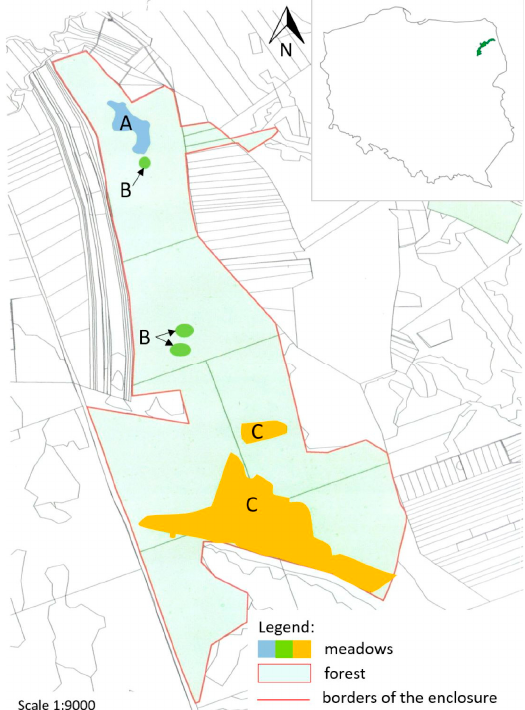
Figure 1. Location of the Biebrza National Park in Poland (right corner) and distribution of the non- forest habitats in the studied site. A—northern meadow, B—mid-forest meadows, C—the southern complex of meadows. Map source: the Biebrza National Park .